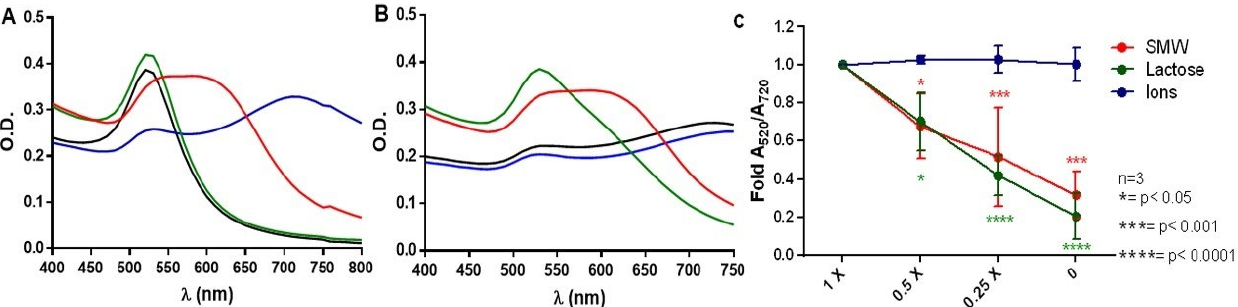
Figure 7. Spectroscopic characterization of the aggregation of AuNPs in synthetic whey (red line), lactose (green line), solution of ion species (blue line) and water (black line) during the incubation of AuNPs at ( A ) 10 min without the addition of NaCl addition and ( B ) 30 min after the addition of NaCl addition. ( C ) Effect of the solution dilution on the aggregation of AuNPs. The curves are based on the average of the results from three independent experiments ( n = 3). Statistically significant differences compared with the controls and different treatments are indicated as * p < 0.05, *** p < 0.001 and **** p < 0.0001.